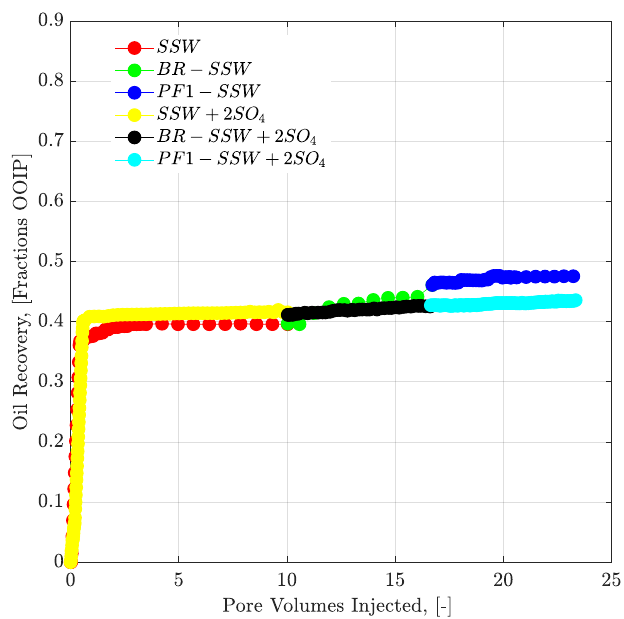
Figure 14. Oil recovery and pressure drop versus PV injected for complex-wet micromodel. Polymer (half to the oil viscosity) flooding in tertiary mode after the brine flood in secondary mode. SSW represents the oil recovery for synthetic seawater. BR-SSW represents the oil recovery from synthetic seawater bump rate. PF1-SSW represents the oil recovery from polymer injection prepared in synthetic seawater having viscosity half to the oil. Similarly SSW + 2SO 4 denotes oil recoveries for synthetic seawater with doubled amount of sulfate.